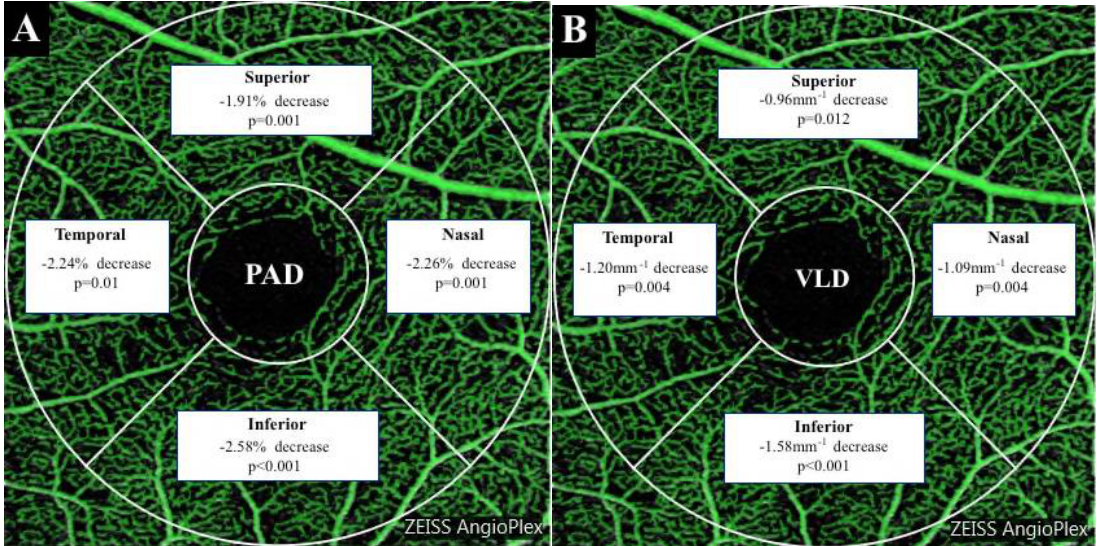
Figure 6. Summary of regional variations in vascular Perfusion Area Density (PAD) ( A ) and Vessel Length Density (VLD) ( B ) between emmetropes and high myopes. These are based on para-foveal region divided in four sectors as per the Early Treatment Diabetic Retinopathy Study grid.